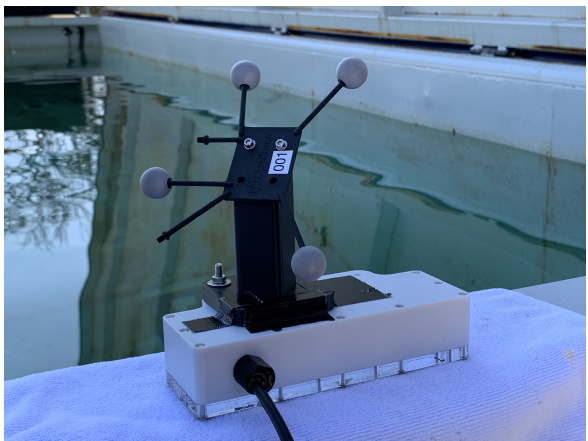
Figure 4. OptiTrack V120:Trio markers mounted on top of the housing to capture ground truth data during the